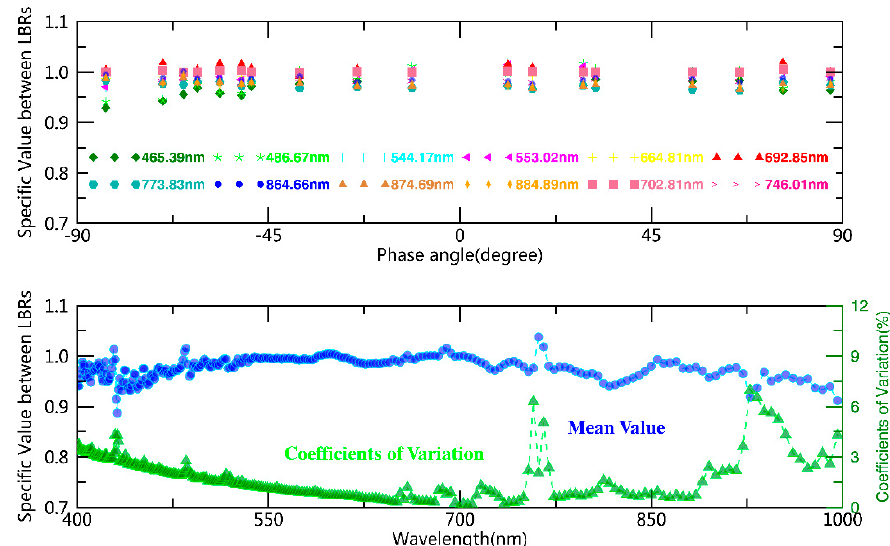
Figure 16. Comparison of the measurements with ROLO lunar model in the lunar band ratio. For the top panel, lunar spectral irradiance is normalized to 700 nm, and the bands are 465.39, 486.67, 544.17, 553.02, 664.81, 692.85, 702.81, 746.01, 773.83, 864.66, 874.69, and 884.89 nm. For the bottom panel, the upper curve is mean values (circle dashed line) of the scatter (top panel) for all the bands, and the lower curve is the coefficient of variation (triangular dashed line) of the scatter.